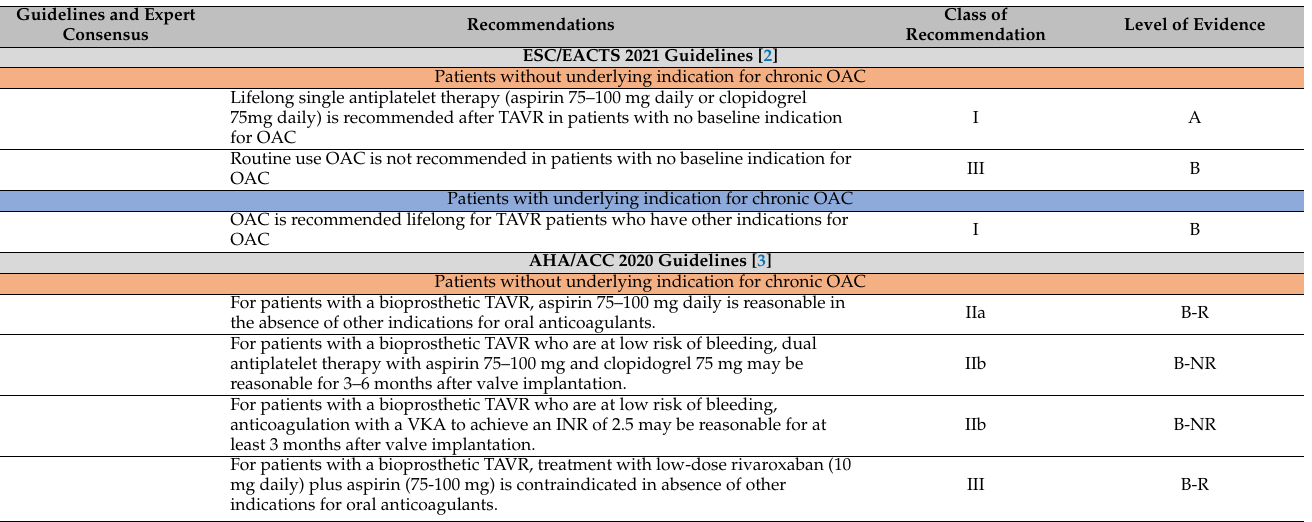
Table 1. Current Recommendations on Antithrombotic Therapy after